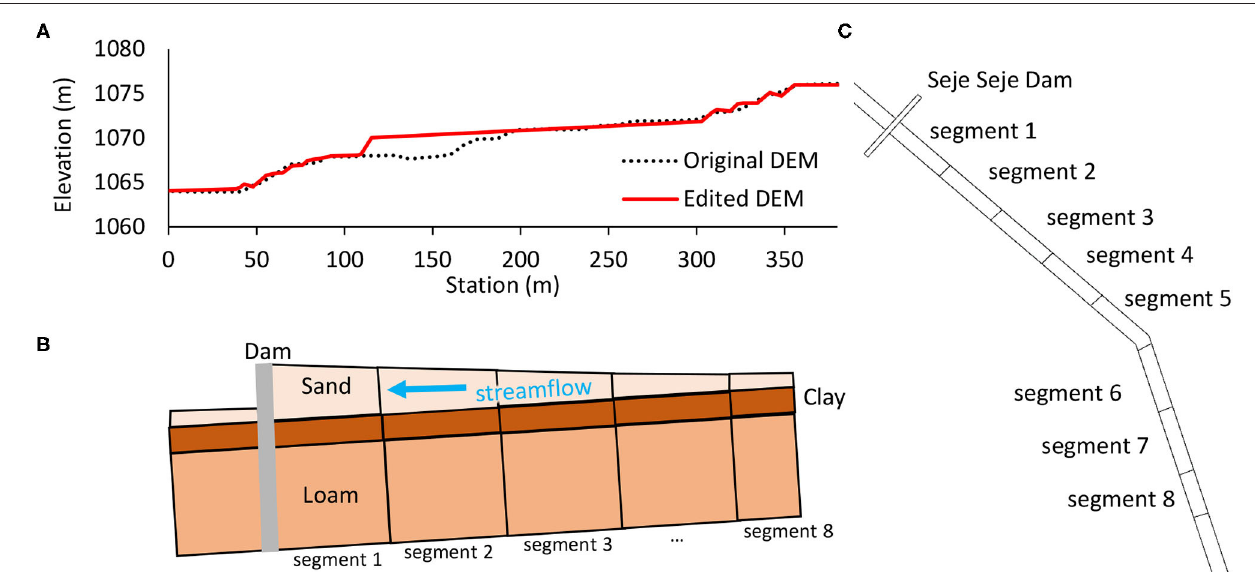
FIGURE 3 | (A) Original elevation profile down the centerline of the stream at the location of the Seje Seje sand dam from the SRTM DEM compared to the edited elevation profile with the sand dam and sand reservoir “built” into the DEM. (B) Representation of the vertical layers design for sand dams. The sand reservoir upstream of the dam structure was represented by sand underlain by a thick clay layer and loam, the primary soil type of the Chididimo watershed. The dam structures are represented by a deep, nearly impervious soil layer. (C) Plan view of the vertical layers design for the Seje Seje sand dam.